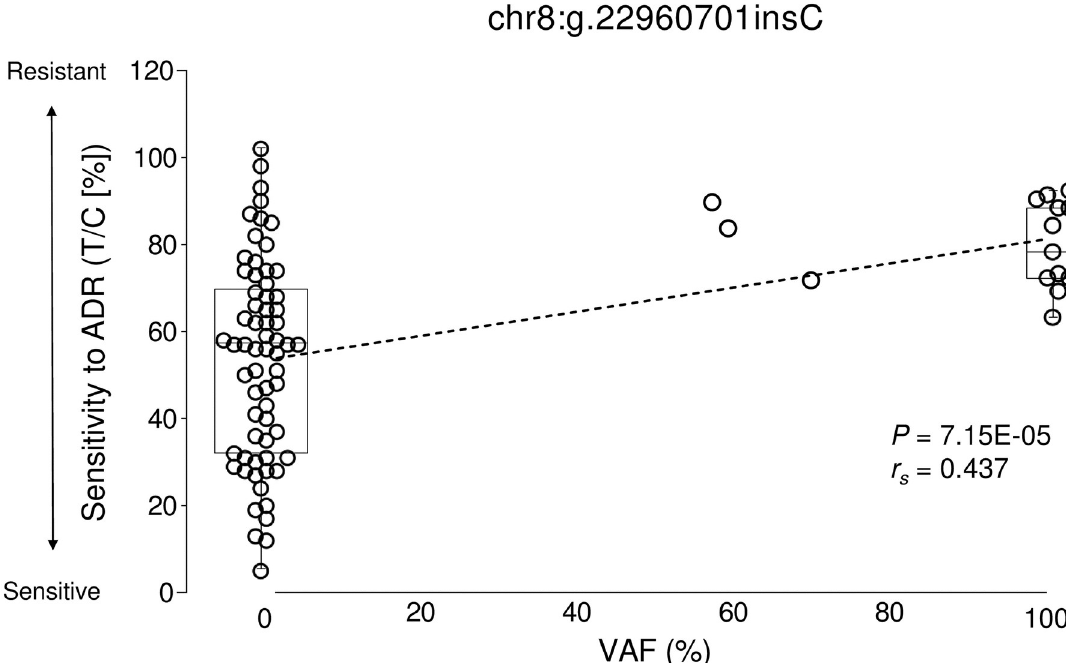
Fig 1. Correlation between variant chr8:g.22960701insC and chemosensitivity to ADR. Chemosensitivity to ADR is represented by relative tumor volume of treated mice (T) with respect to that of the control mice (C). Xenografts with a higher VAF exhibited a poorer response to ADR than those with a lower